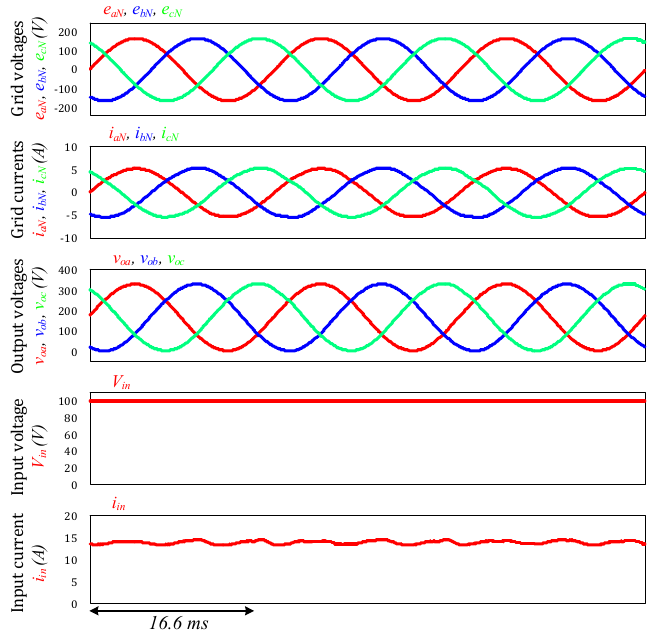
Figure 5. IFBI simulation results with SOHC compensation strategy.